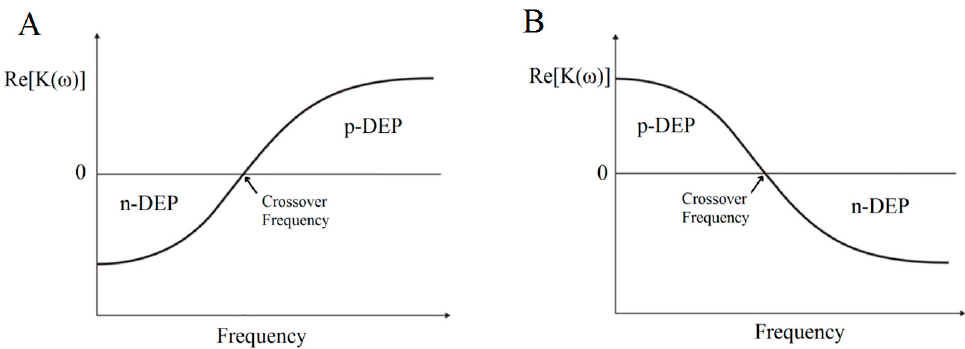
Figure 2. DEP spectrum (Re[ K ( ω )] vs. frequency) of a polarizable particle. ( A ) when σ p < σ m and ε p > ε m ; ( B ) when σ p > σ m and ε p < ε m .